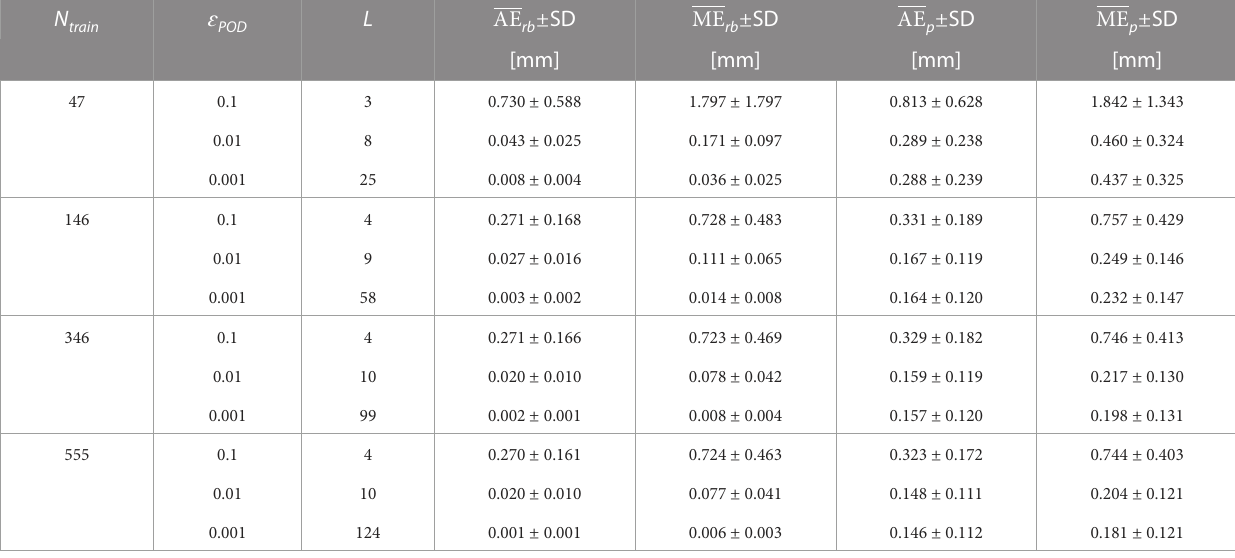
TABLE3 AnalysisofML-basedROMperformanceconsideringdifferenttolerances ( ɛ POD ) ,numbersofRBs ( L ) andtrainingdatabasesizes ( N train ) .Theresultsare obtainedusingtheBéziercurveparameters ( μ B ) asGPRpredictors.